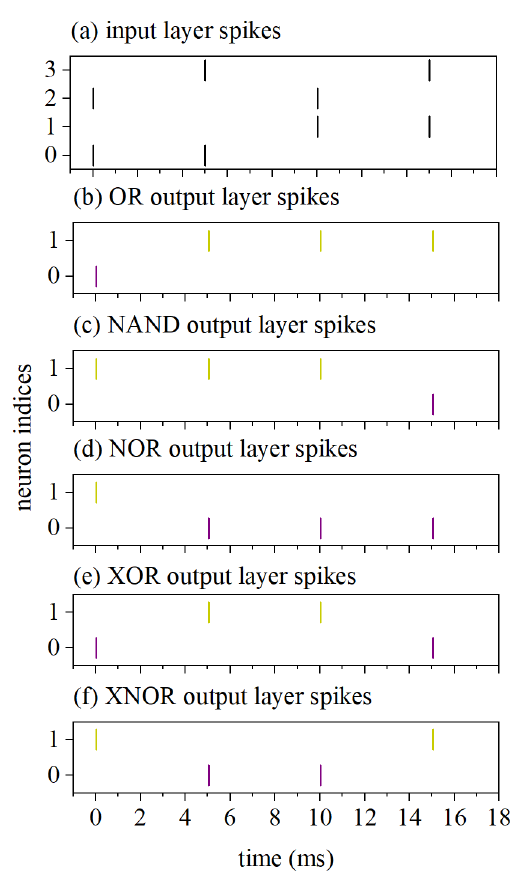
Figure 7. The input layer spikes and the output layer spikes of other 5 kinds of the SNN logical operation module: OR, NAND, NOR, XOR, XNOR.